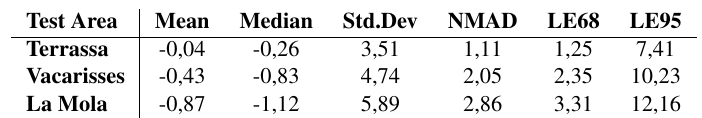
Table 1: Cartosat-1 assessment results